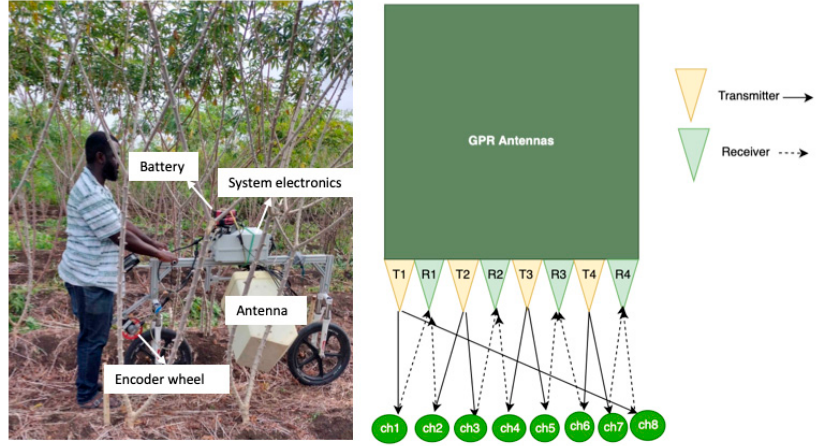
Figure 1. ( Left ) GPR device; ( right ) antenna configuration showing 8 channels of antenna pairing. Table 1. Data acquisition parameters.